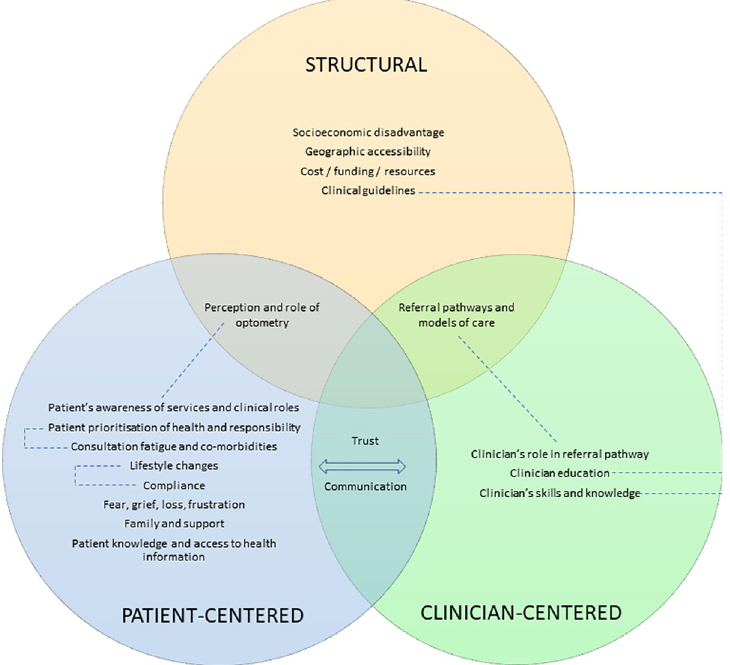
Fig 3. Overview of three categories of influence in a Venn diagram: Structural, patient-centered, and clinician- centered themes generated by the qualitative analysis and their overlap and relationships. Themes were categorised into structural (yellow circle), patient-centered (blue circle), and clinician-centered (green circle) categories of influence. Those themes that overlapped more than one category of influence such as for example trust and communication were placed at the appropriate intersection of the Venn diagram. Significant relationships between themes are highlighted with dotted lines. Note that any theme could be classified as a barrier, enabler, or both, depending on the eyecare professional’s individual